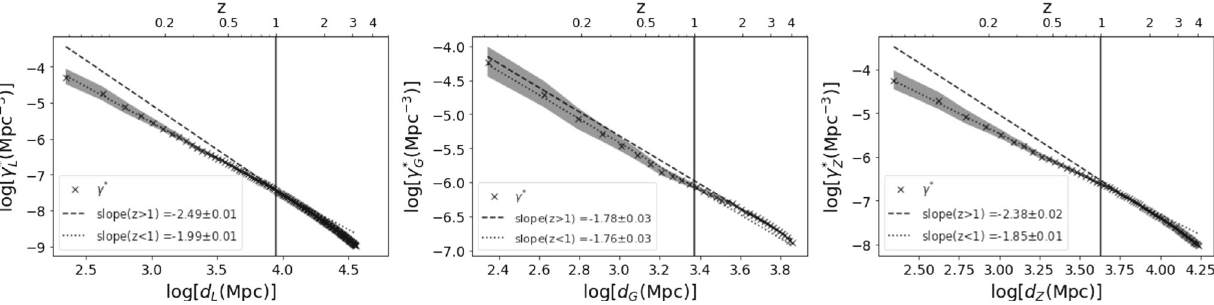
Fig. 13 Log–log graph of γ ∗ , γ ∗ and γ ∗ respectively vs. d L , d G and d z obtained with the blue SPLASH star forming galaxy subsample in the L G z ranges z < 1 and 1 ≤ z ≤ 4 and respective distance measures. All results were obtained considering H 0 = 70 km/s/Mpc